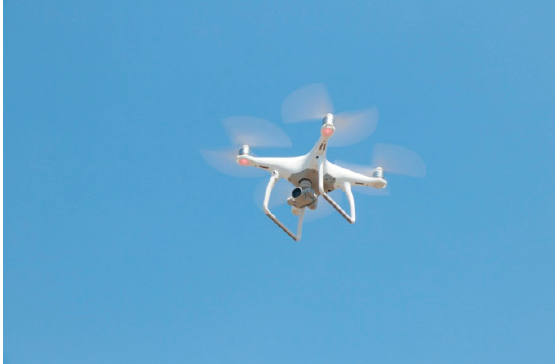
Figure 2. Phantom 4 in our experimental field Table 1. Technical characteristics of Phantom 4 and its onboard camera.